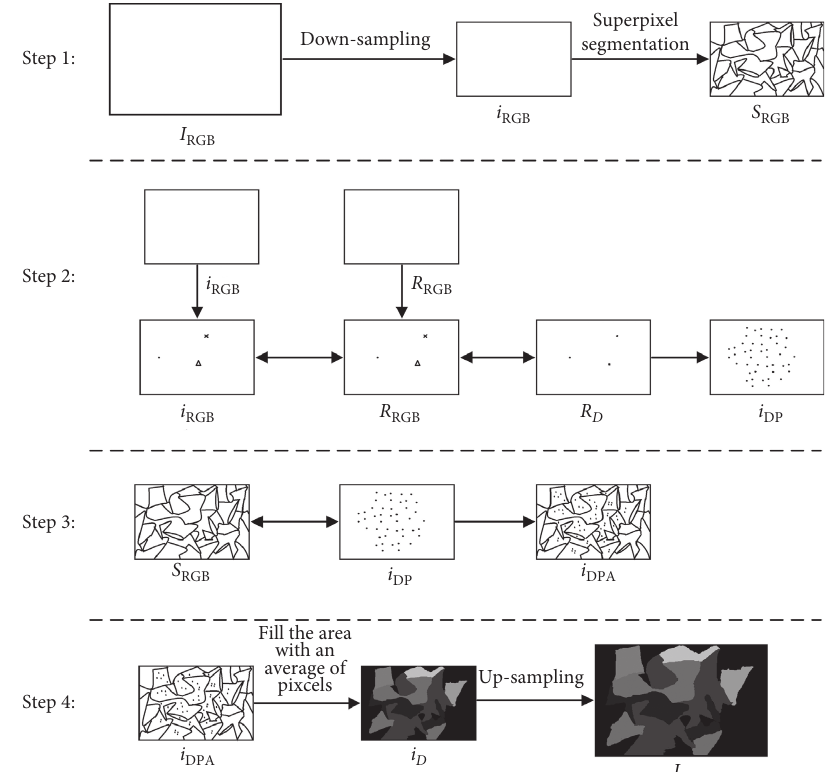
Figure 2: The algorithm flow chart.